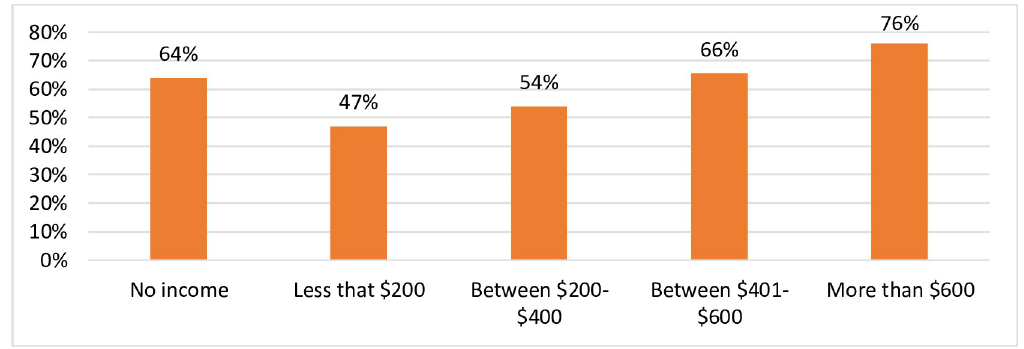
Fig 4. Distribution of respondents maintaining wellbeing by income: South Australia 2020. Source: Figures generated by the authors from results of Impact of COVID-19 on the wellbeing of individuals in South Australia 2020 survey.